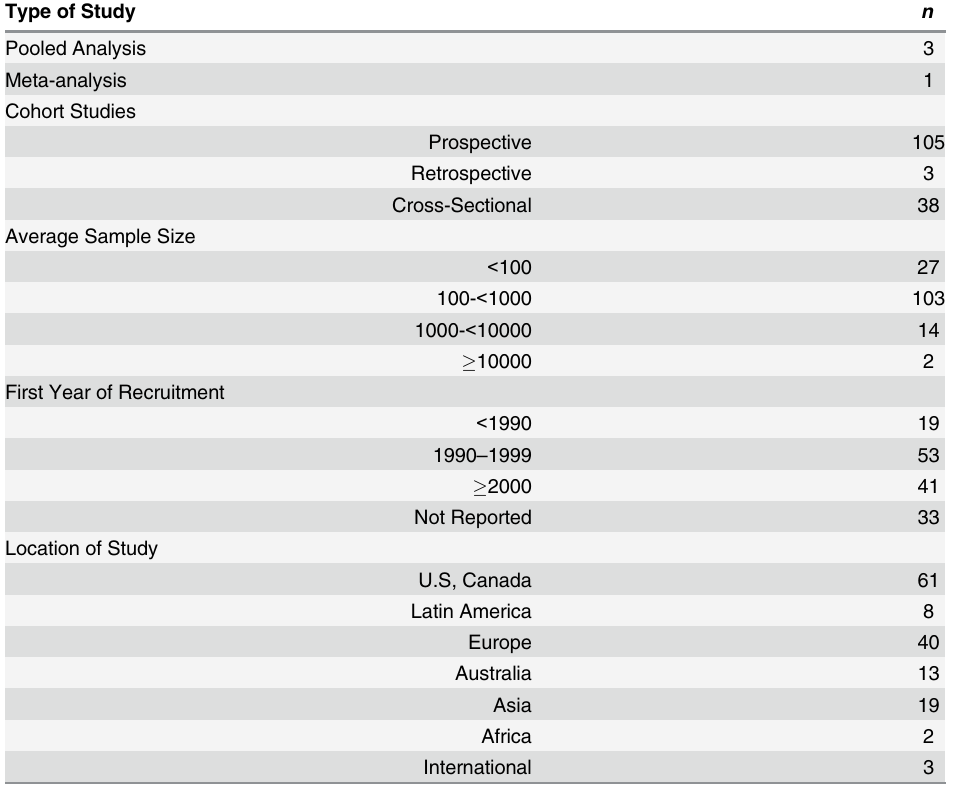
Table 1. Summary of Characteristics of the Included Studies.